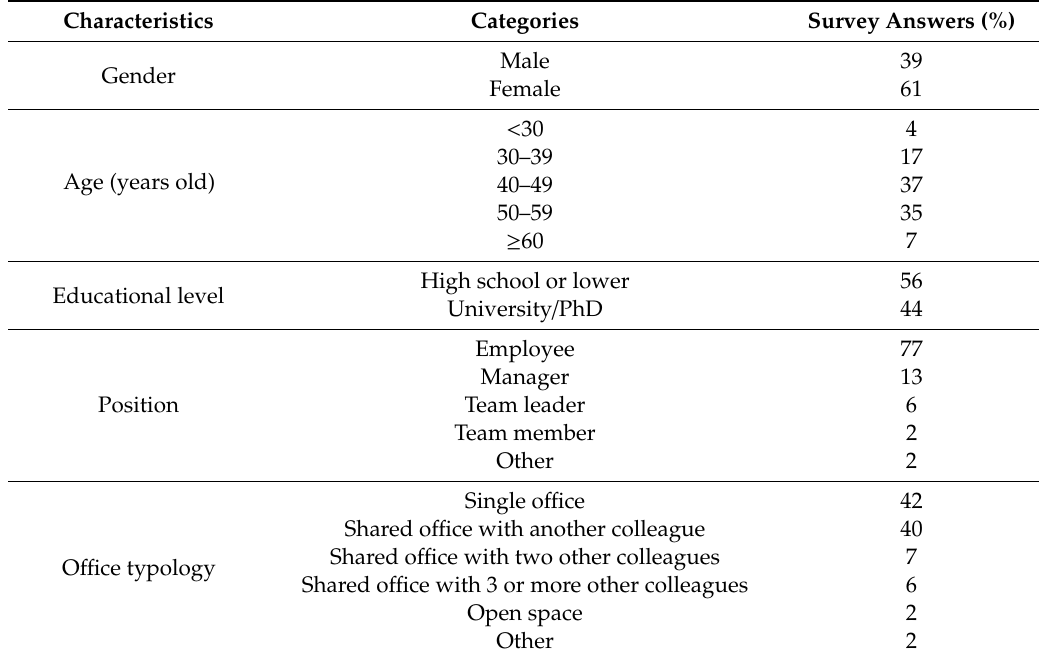
Table 2. Respondents’ characteristics (N = 922).